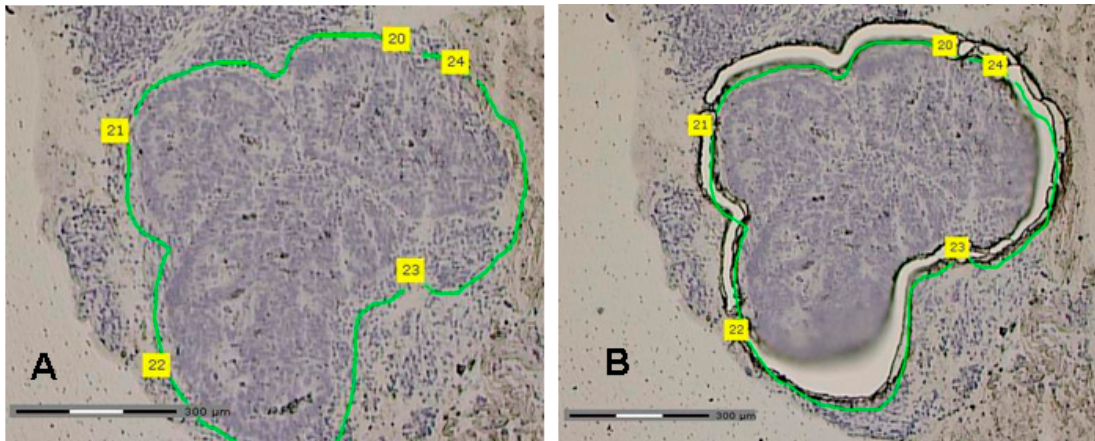
Figure 3. Laser capture micodissection of tumor biopsies. ( A ) The tumor tissue is circled by a green line; ( B ) the laser dissects the tumor tissue which will be picked up and separated for proteomic analysis. Scale bar = 300 µm, numbers are starting points for the laser.